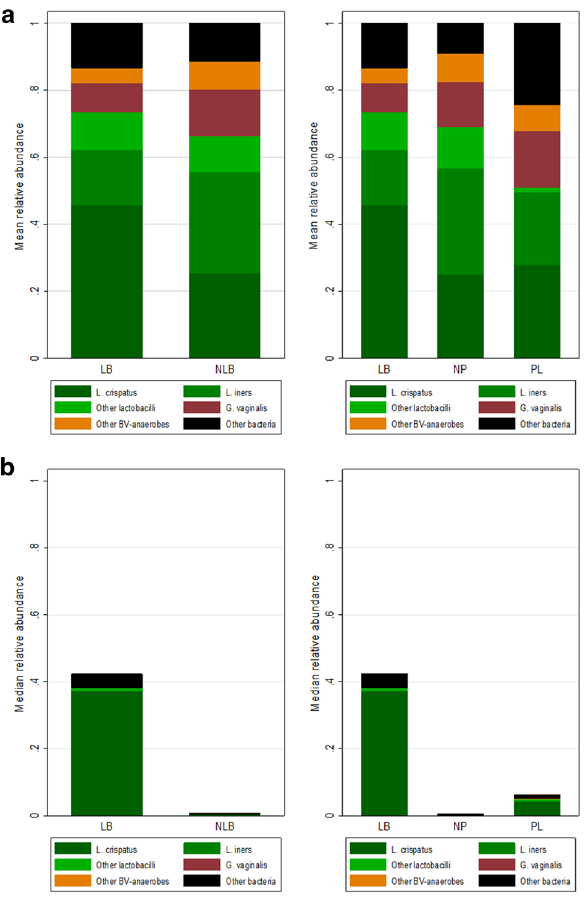
Figure 2. Relative abundance of prespecified bacterial groups by birth outcome. Stacked bar graphs of mean ( a ) and median ( b ) relative abundances of prespecified bacterial groups in the live birth (LB) versus no live birth (NLB) groups. The NLB group was further divided into the no pregnancy (NP) and pregnancy loss (PL) group. BV, bacterial vaginosis; G. vaginalis , Gardnerella vaginalis ; L. crispatus , Lactobacillus crispatus ; L. iners , Lactobacillus iners .